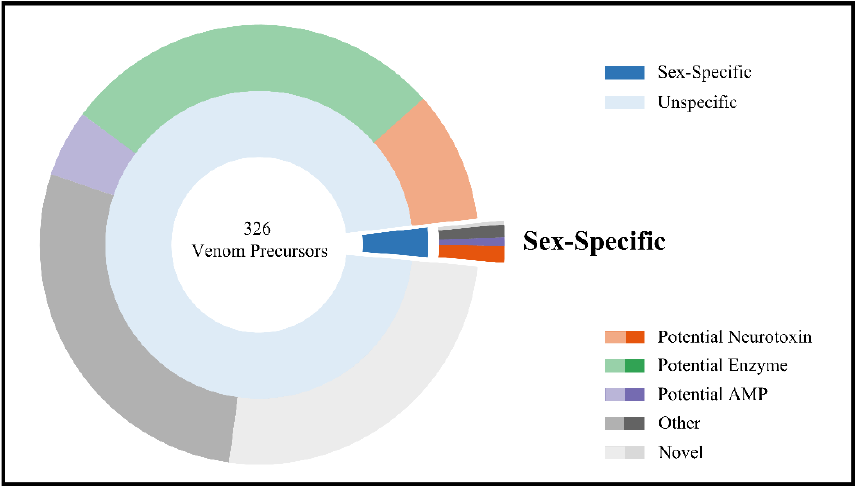
Figure 4. Pie chart highlighting the fraction of venom precursors that were confirmed to be down- or up-regulated (“sex-specific”) in males of Euscorpius italicus (inner circle). In the outer circle, venom compounds are classified based on similarities to sequences from UniProt [19]